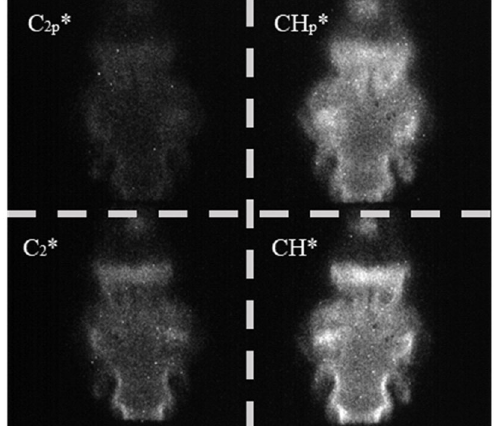
Figure 4. Sample instantaneous image from the four-line chemiluminescence sensor. For clarity, the four individually filtered bands have been segmented.